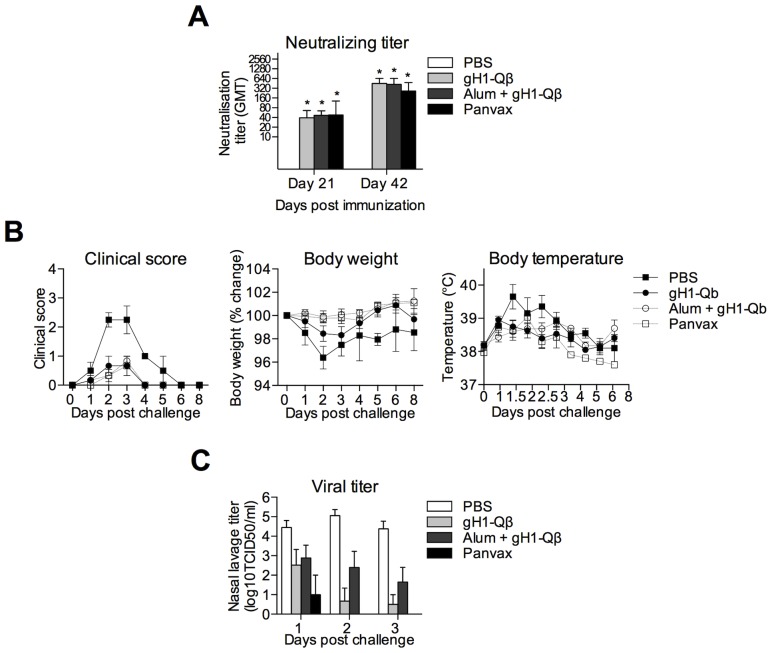
Alum-adjuvanted gH1-Qβ elicits protective immunity in Ferrets.Ferrets were immunized twice intramuscularly on days 0 and 21 with 100 µg of non-adjuvanted gH1-Qβ, 100 µg alum-adjuvanted gH1-Qβ or 15 µg Panvax. (A) Geometric mean (and 95% confidence intervals) for neutralizing antibody responses. A two-way repeated-measures ANOVA was performed on the log transformed titers with time point and vaccine as the factors. Both factors and their interaction were found to be significant at the 5% significance level and Bonferoni’s corrected multiple comparison test used to compare between 2 groups. Significant differences between vaccine response and PBS control are outlined with *, p<0.05. (B) Mean (and standard error) of activity and respiratory scores (0 indicating no changes, 1 indicating reduced activity and mild respiratory signs, and 2 representing depressed behavior and moderate respiratory signs), body weight and body temperature measured over the 6 days following challenge with pH1N1. Clinical scores and body weight for both the alum-adjuvanted and non-adjuvanted gH1-Qβ and Panvax were not significant from each other (p>0.05), but significantly different from the control PBS group as determined by linear mixed model (p<0.05). (C) Mean (and standard error) of viral titers in nasal washes at indicated days after challenge with pH1N1. Titers for all vaccines were significantly different from the control PBS group as determined by linear mixed model (p<0.01).